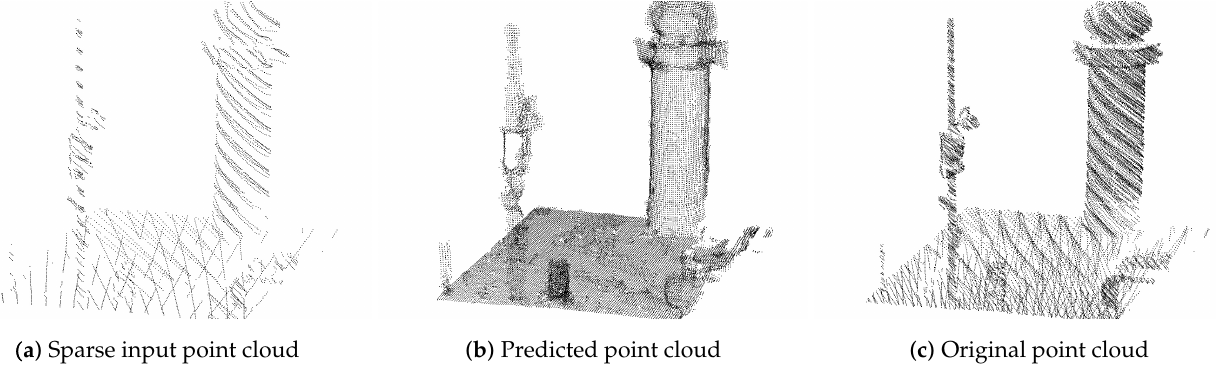
Figure 11. Scene completion task for one chunk point cloud in Town1 ( T 1 ) of CARLA test data (training on CARLA data).